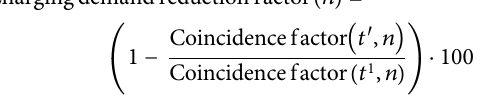
Frontiers in Energy Research |